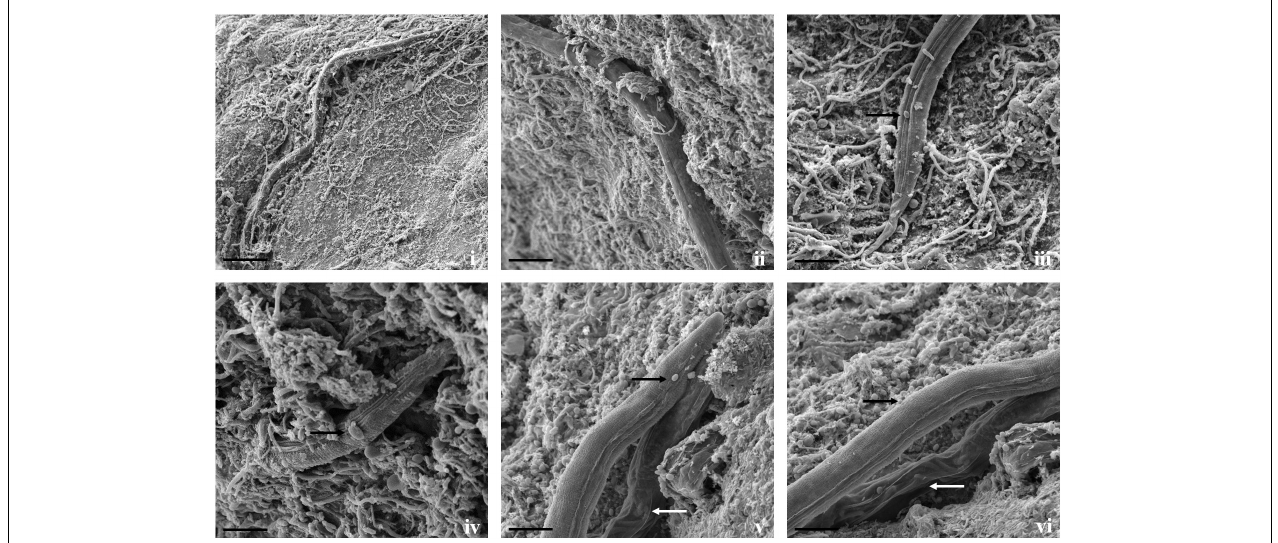
FIGURE 6 | Scanning electron micrographs of interaction between T. cylindrosporum Tc_RK and C. elegans . (i,ii) Fungal colonization and parasitization on nematodes body (scale bar = 50, 20 µ m), (iii,iv) attachment of fungal spores onto nematode cuticle (black arrow) (scale bar = 20 µ m), (v,vi) comparison between fungus colonized nematodes having hypha inside its body (white arrows) and not colonized worms (black arrow) (scale bar = 20 µ m). TABLE 1 | Evaluation of tested isolates on M. incognita infection and growth parameters of tomato at 45 dpi. Treatments Growth parameters Infection parameters Plant length Plant wet weight Plant dry weight Number of galls Number of egg Number of eggs (cm) (g) (g) masses per egg mass Arthrobotrys